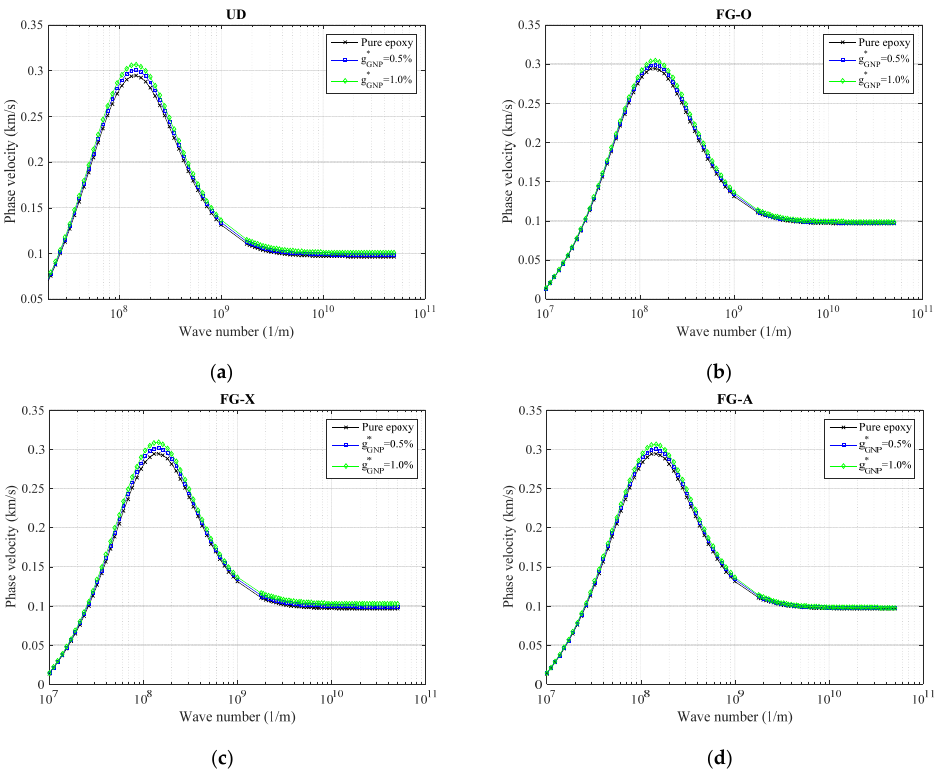
Figure 4. The variation of phase velocity versus weight fraction of GNPs for ( a ) UD, ( b ) FG-O, ( c ) FG-X, and ( d ) FG-A patterns of GNPs ( α = π /4, ℓ = 1 nm, μ = 10 nm, N l = 10).